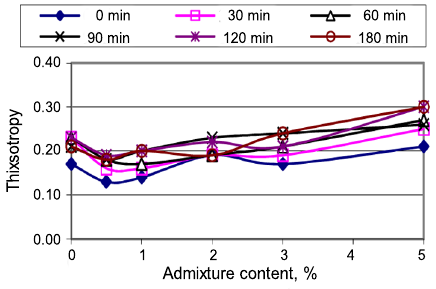
Fig. 18. Thixotropy of cement paste with CEM II N